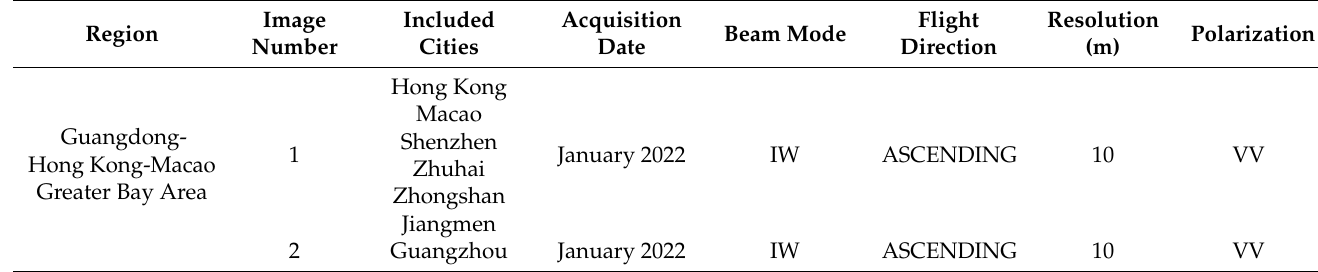
Table 1. Basic information of the Sentinel-1A SAR data in experiment.